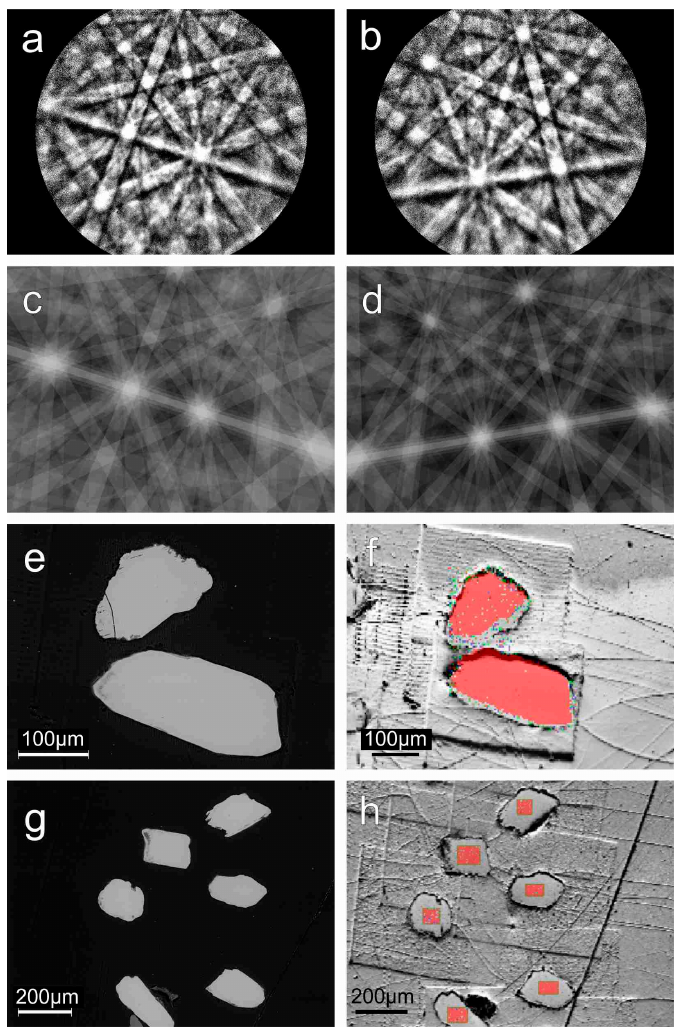
Figure 4. Results of electron backscattered diffraction analysis (EBSD) study of selected rutile grains. ( a , b ) Experimental EBSD Kikuchi patterns of rutile grains GLA-23 ( a ) and GLA-24 ( b ); ( c , d ) simulated Kikuchi pattern of the same rutile grains GLA-23 ( c ) and GLA-24 ( d ); ( e ) BSE (backscattered electron) image of rutile grains GLA 23 (top) and GLA-24 (bottom); ( f ) FSE (forescattered secondary electron) image of rutile grains GLA-23 and GLA-24 superimposed on EBSD mapping: red—rutile, single blue pixels*—anatase, single green pixels*—brookite; ( g ) BSE image of six more rutile grains MO-9—MO-14, ( h ) FSE (forescattered secondary electron) image of rutile grains MO-9—MO-14 superimposed on EBSD mapping: red—rutile, single blue pixels*—anatase, single green pixels*—brookite; *—single pixels of apparent anatase and brookite phase are most likely just a misidentification of the Bruker esprit software, Bruker Nano GmbH, Berlin, Germany used in EBSD study.